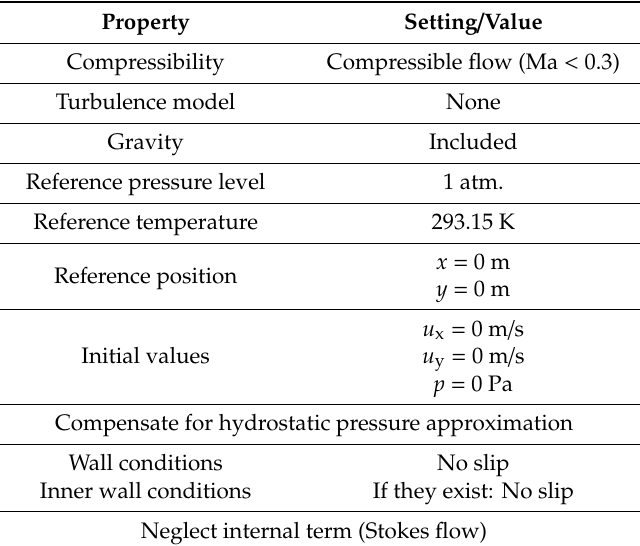
Table 2. Settings for heat transfer in fluids